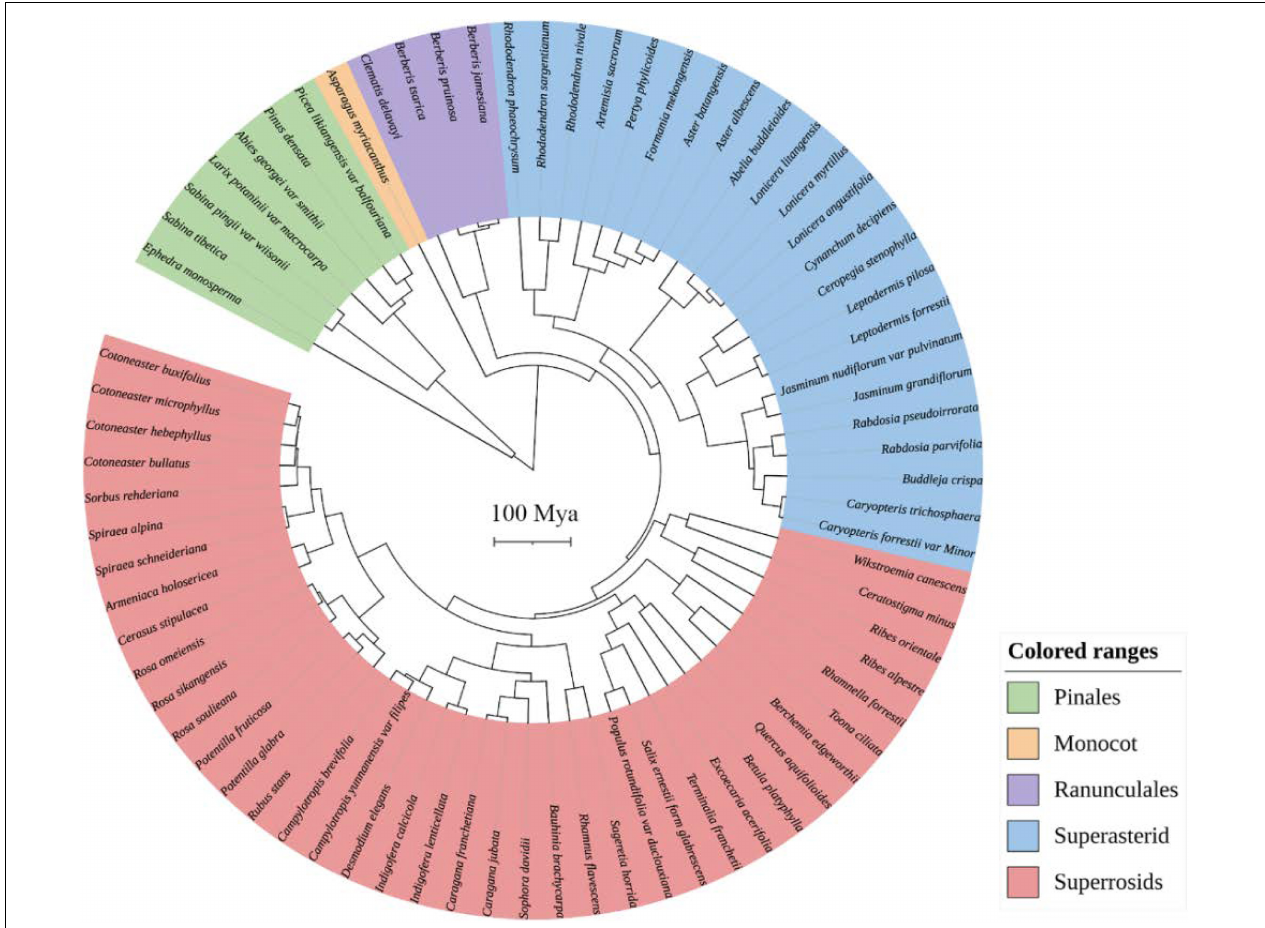
FIGURE 2 | The phylogenetic tree of woody plant species was recorded in all plots on the west and east slopes of Hongla Snow Mountain, assembled from molecular